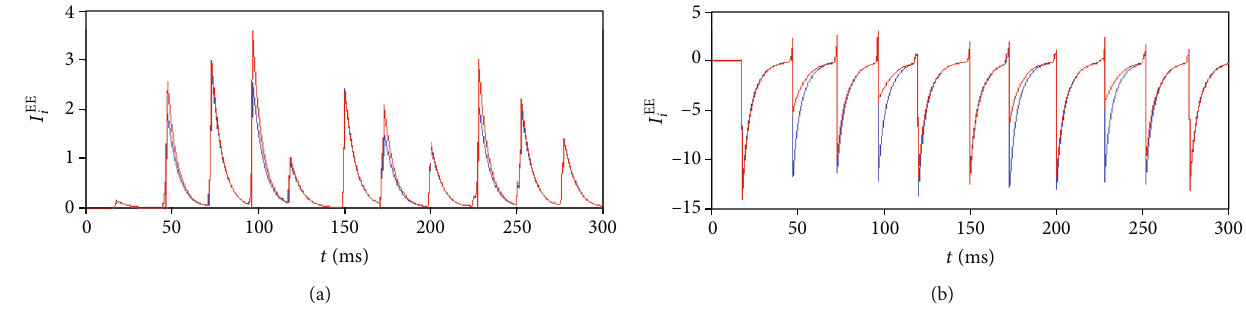
Figure 10: Comparisons of the synaptic currents received by a neuron with a higher fi ring rate (red) and a neuron with a slower fi ring rate (blue): (a) total synaptic currents from excitatory neurons; (b) total synaptic currents from inhibitory